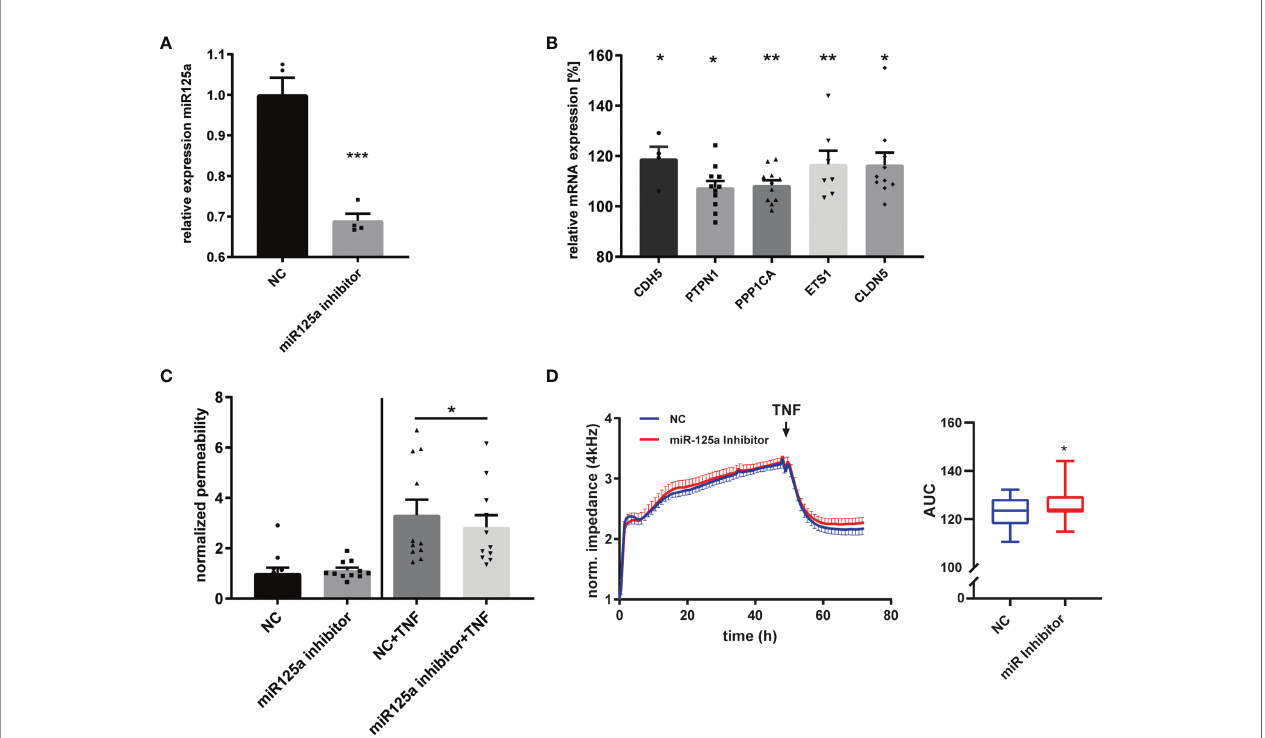
FIGURE 4 | MiR-125a inhibition and its impact on endothelial barrier function. (A) Expression of miR-125a in HUVEC after transfection of a miR-125a-inhibitor ( “ Antimir ” ) as measured by qRT-PCR (n=4, ***p<0.001). (B) mRNA levels of CDH5, PTPN1, PPP1CA, ETS1, CLDN5 after transfection of a miR-125a-inhibitor compared to a scramble control (n=10-11, **p<0.01, *p<0.05). (C) Endothelial permeability as measured by FITC-Albumin passage across an endothelial monolayer in basal (left) and in fl ammatory (right) conditions after transfection of a miR-125a-inhibitor or a scrambled control (NC). n=11, *p<0.05. (D) Impedance measurement of the endothelial monolayer after miR-125a inhibition (red) compared to scrambled control (NC, blue). n=11,